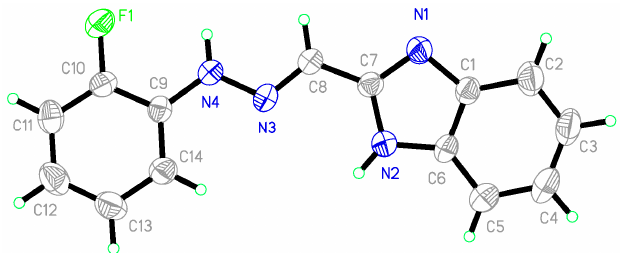
Figure 2. X-ray diffraction structure of 6b , thermal ellipsoids was drawn on the 35% probability.